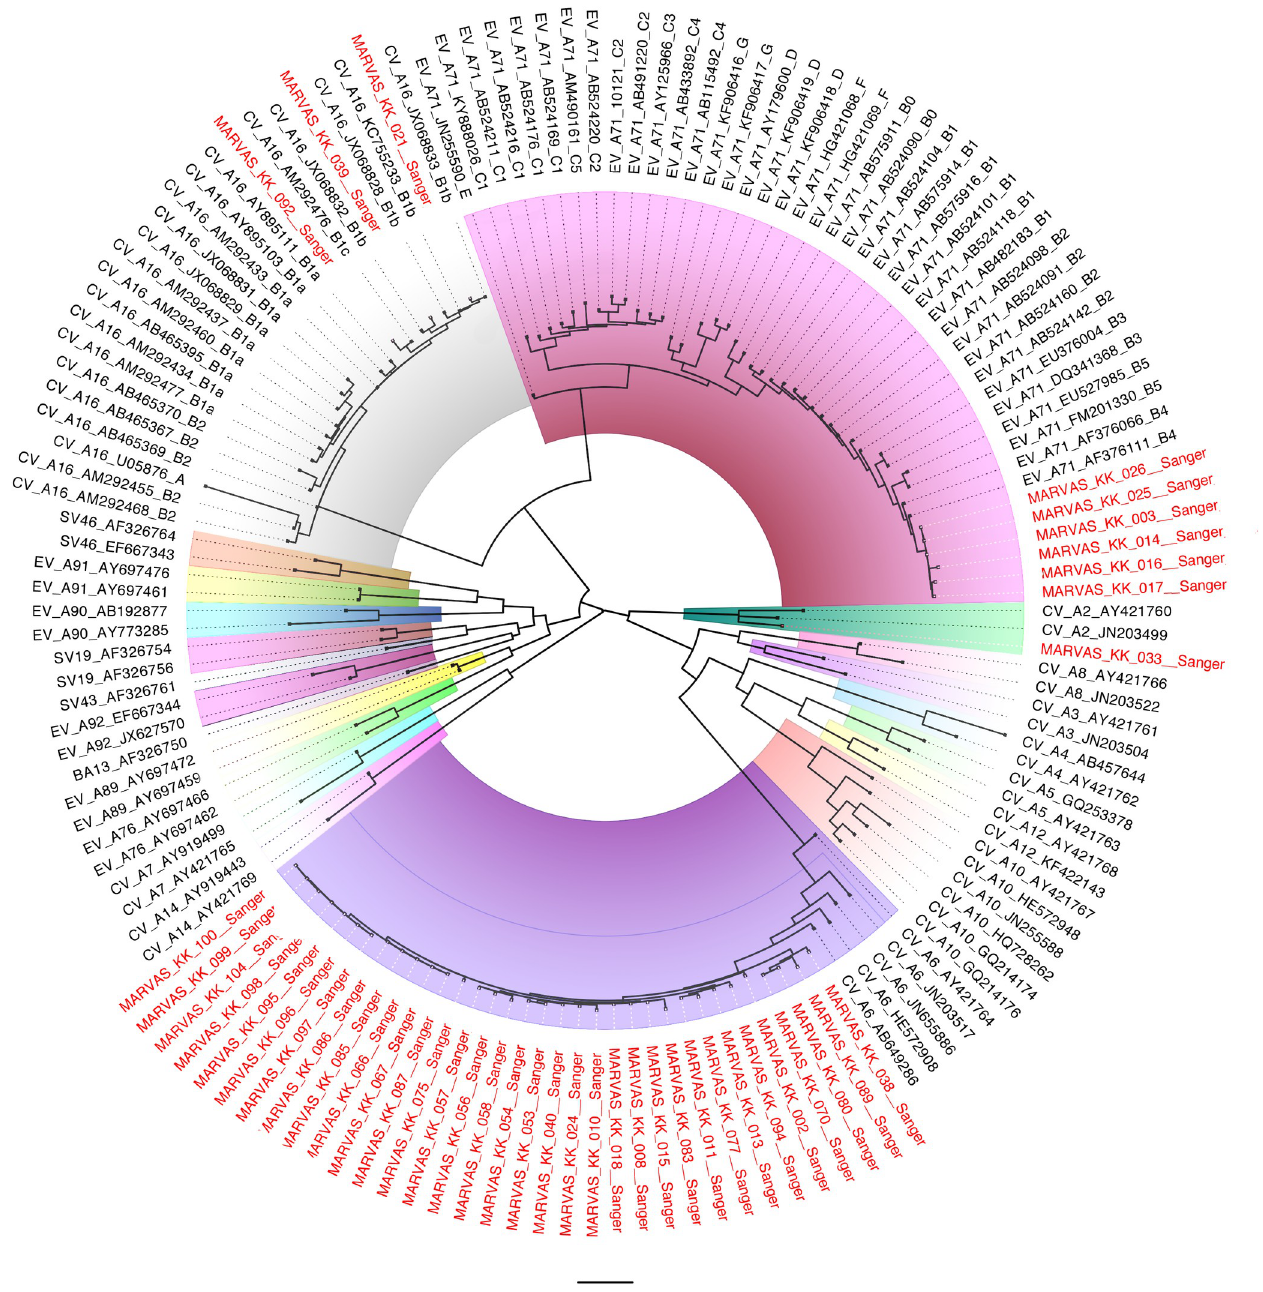
Fig 2. Maximum likelihood phylogeny of partial VP1 sequences from HFMD symptomatic patients. Midpoint rooted phylogenetic tree was constructed by Sanger sequencing of partial VP1 sequence using RAxML with the general reversible time substitution model and gamma-distributed rate heterogeneity. Clades were highlighted for different serotype of enteroviruses. Sequences from the symptomatic HFMD cohort were denoted with red at